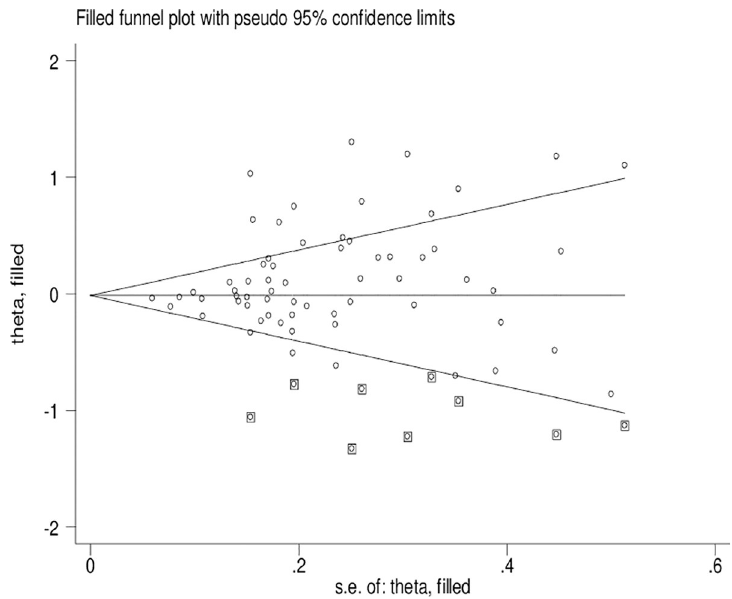
Fig 2. The duval and tweedie nonparametric “trim and fill” method’s funnel plot of the CYP1A1 T3801C polymorphism (TC + CC vs. TT).